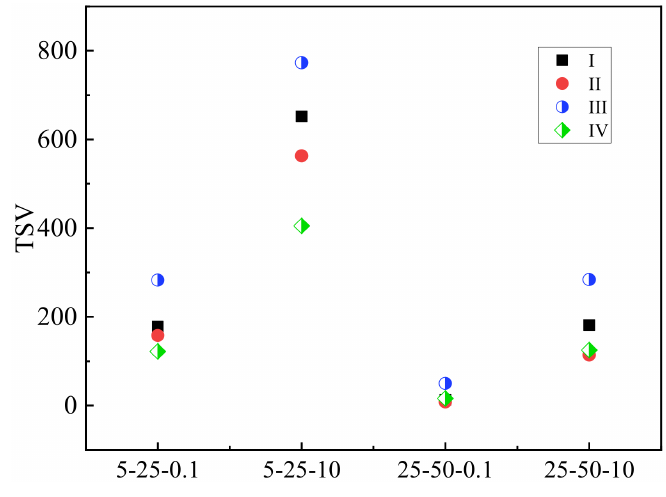
Figure 14. Temperature sensitive